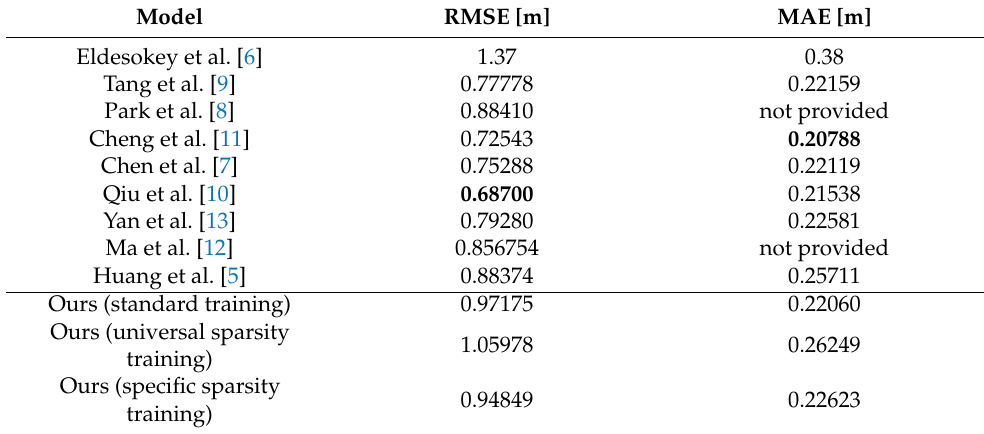
Table 1. Performance of the RGB-guided depth completion methods on the KITTI validation set.